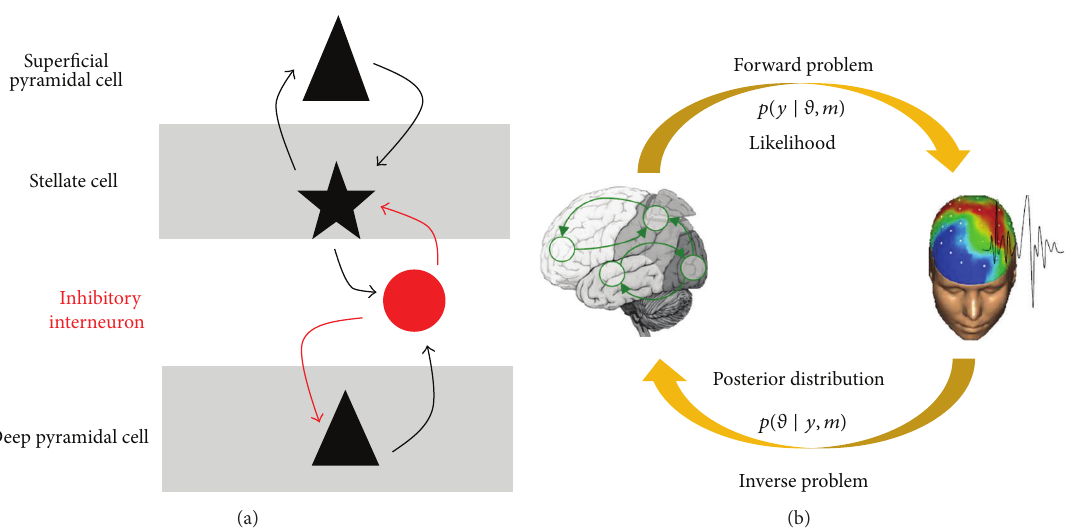
Figure 3: (a) Canonical microcircuit (CMC) epitomizes a given cortical column and comprises four neuronal populations connected through excitatory and inhibitory projections (modified from [24]). (b) Schematic diagram of the DCM algorithm functioning. The forward problem rests upon a neuronal model (as for (a)) and provides a likelihood function, which is then used in the inverse problem to derive a posterior distribution for the neuronal